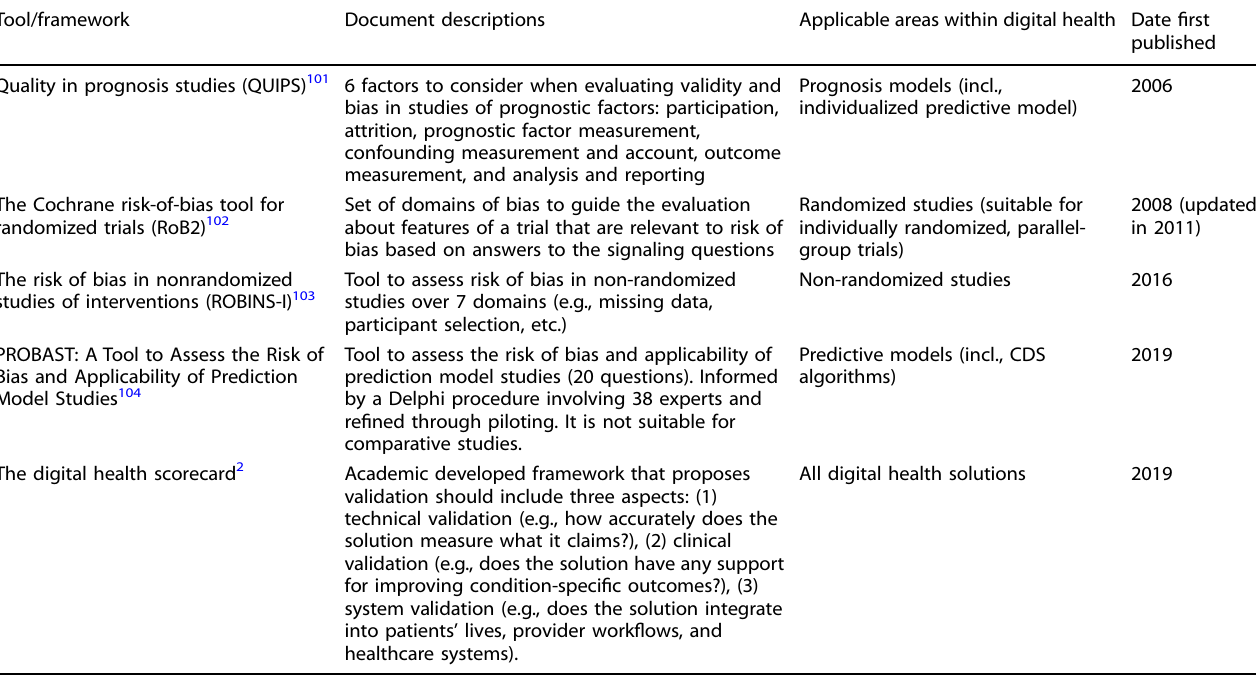
Table 2. Selected academic recommendations relevant to undertaking evidence generation studies for digital health solutions (not exhaustive).